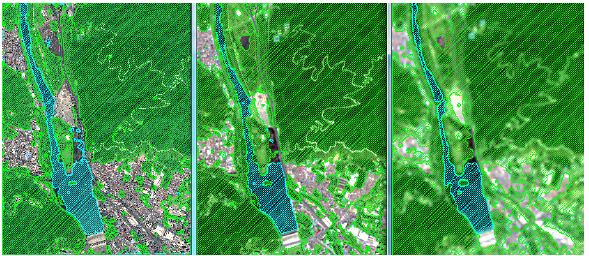
Figure 10. Comparison of vegetation and water separation with the same settings of binarization thresholds for images from SuperView-1A satellite for May 5, 2017 (in the left), Sentinel- 2A satellite for April 28, 2017 (in the middle) and Landsat-8 satellite for May 7, 2017 (at the